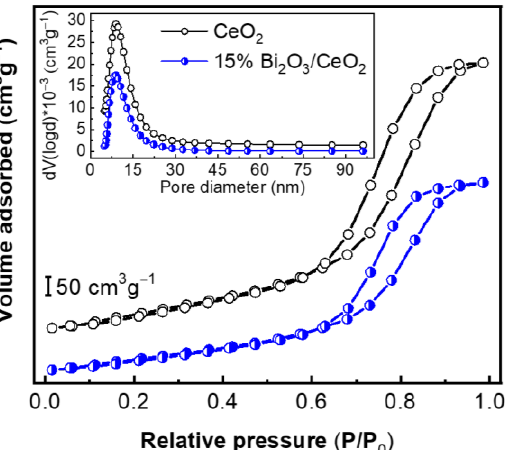
Figure 3. N 2 adsorption/desorption isotherms and corresponding pore size distribution (inset) for prepared CeO 2 compared to 15% Bi 2 O 3 /CeO 2 heterojunctions as indicated. Table 1. Consequence of Bi 2 O 3 inclusion on physicochemical characteristics of CeO 2 , namely, surface area (S BET ), absorption edge (Abs. edge), and determined bandgap energies (E g ). The consistent photoreduction of CO 2 to CH 3 OH after 9 h irradiation is listed. The corresponding photocurrent intensities are also stated in the last